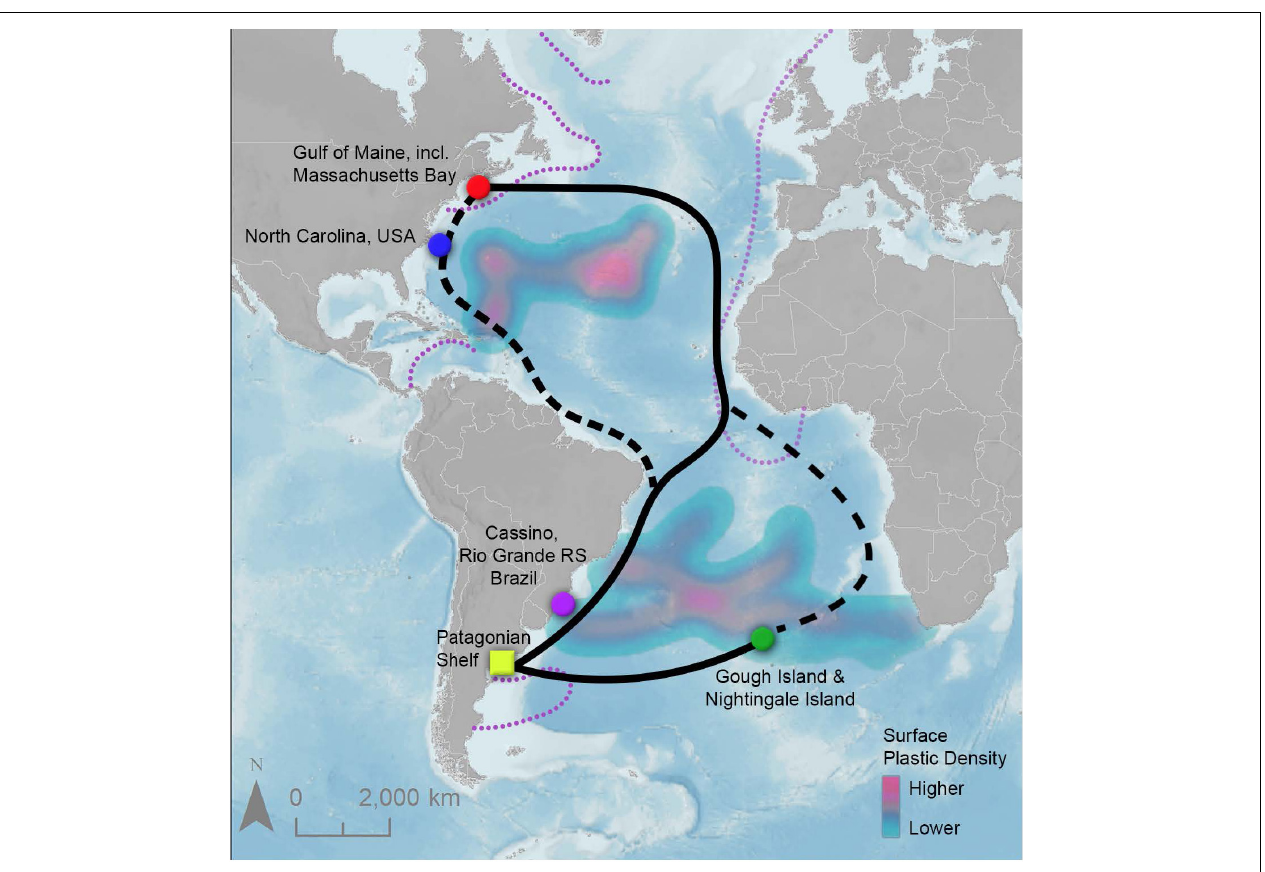
FIGURE 1 | Map of Great Shearwater migratory routes (black and dashed lines) and sample collection locations (marked by colored circles). Solid lines are considered the dominant migratory route based on tracking data. No samples were collected off the Patagonian Shelf (marked by the yellow square), but this location is heavily used by both adult and juvenile Great Shearwaters as a staging and feather molt location 52 surrounding trans-equatorial migration. Purple dashed lines indicate areas where fishing activity may contribute plastics to the environment. Surface plastic density data is derived from a compilation of literature sources curated by the NOAA Marine Debris Program, freely available